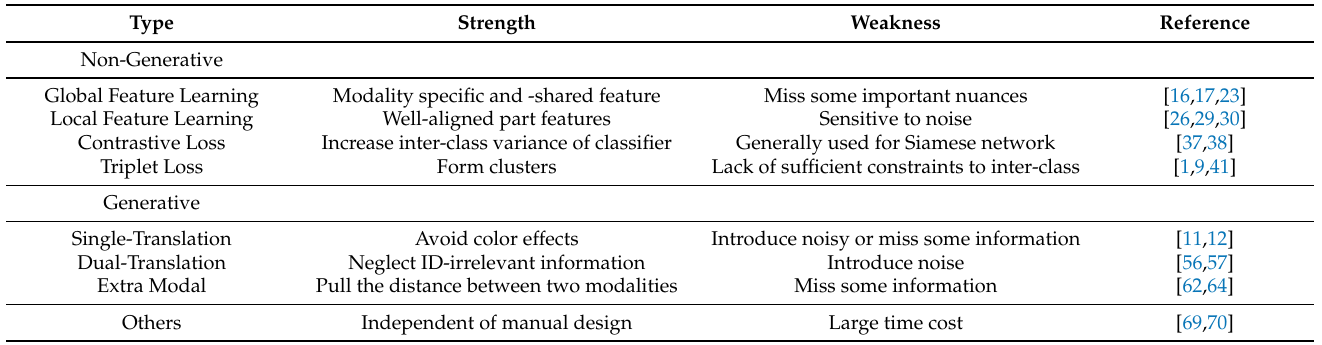
Table 1. A summary of non-generative-based and generative-based